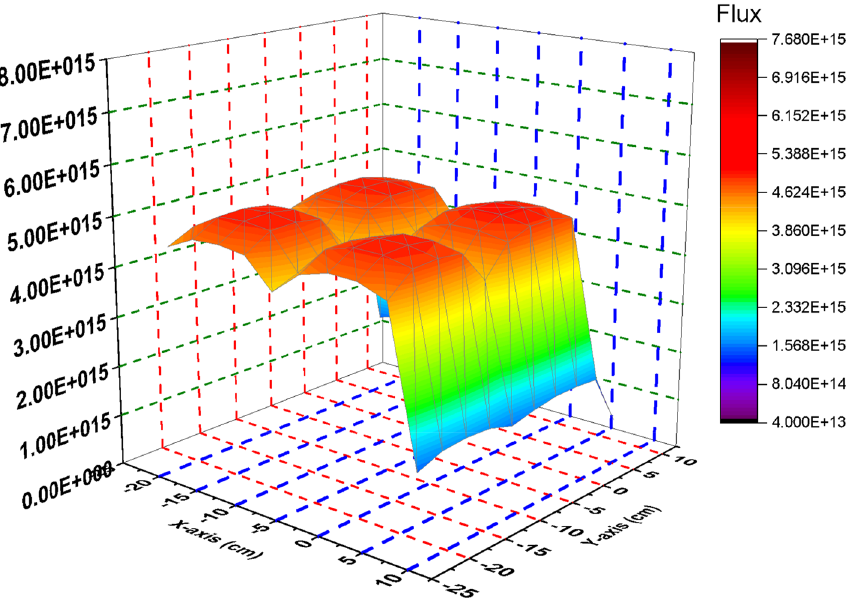
Figure 7. Fast Flux distribution for the four bundle using 10 meshes in case of C in the control blade.